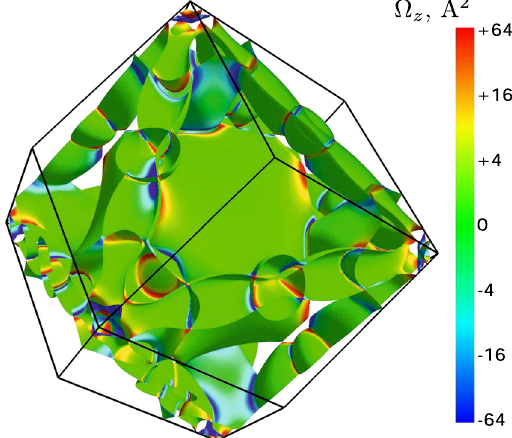
Fig. 2 Fermi surface of bcc iron. Color shows the Berry curvature Ω z on a logarithmic scale. Figure produced using F ermiSurfer 46 software.